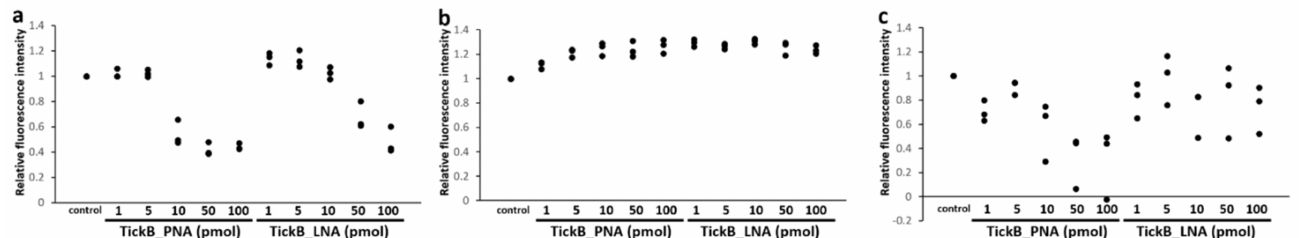
Figure 2. Change in the relative fluorescence intensity of PCR products in the presence of various concentrations of blocker nucleic acids. In each graph, the x -axis shows the type and amount of blocker (TickB_PNA or TickB_LNA) added to the reaction mixture, and the y -axis shows the relative fluorescence intensity of the bands. PCR and fluorescence intensity measurements were performed in triplicate. For each trial, the fluorescence intensity in the absence of the blocker (control) was set to 1.0, and the relative fluorescence intensity with the blocker is presented as a relative value. The types and concentrations of plasmids as templates were ( a ) partial Haemaphysalis longicornis 18S rRNA gene at 2.5 × 10 6 copies/reaction, ( b ) partial Theileria orientalis 18S rRNA gene (ToP) at 2.5 × 10 6 copies/reaction, or ( c ) ToP at 2.5 × 10 2 copies/reaction.